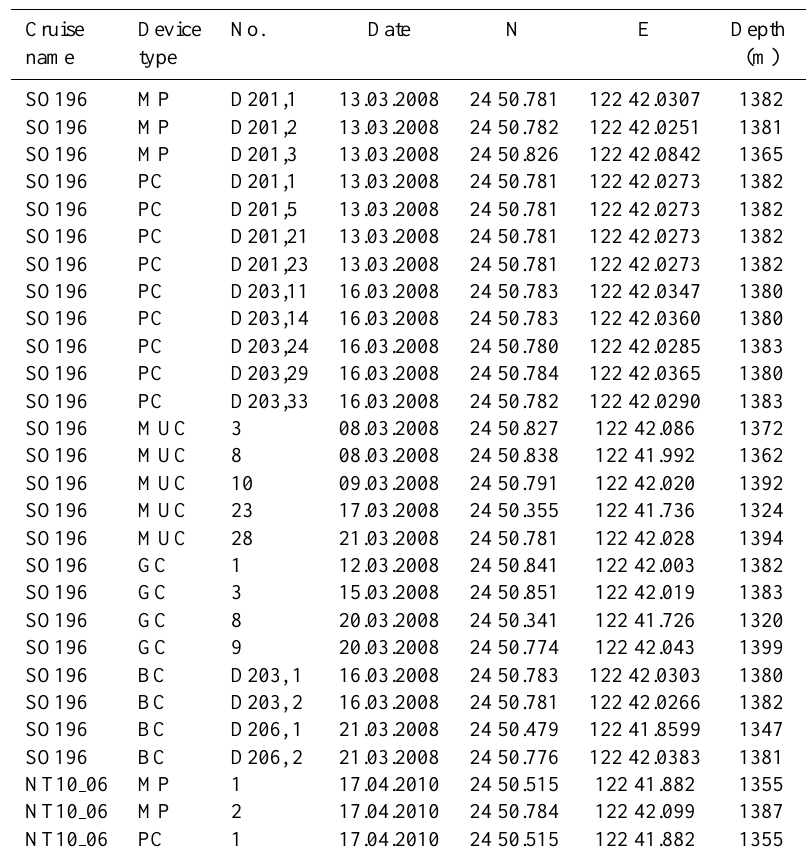
Table 1. Station list with sampling dates and